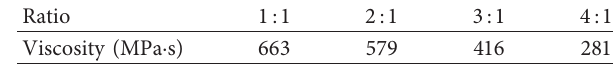
Table 5: Test results of grout viscosity.